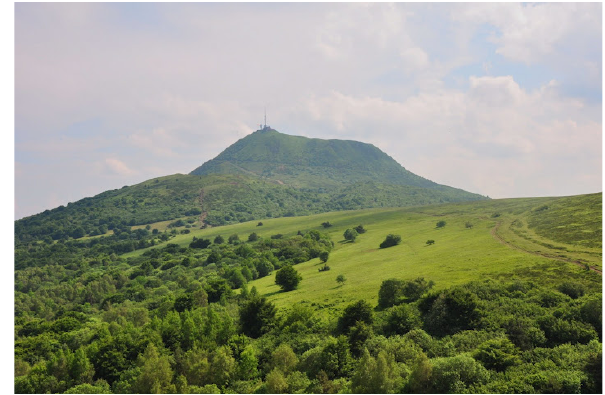
Fig. 1. Measurement site